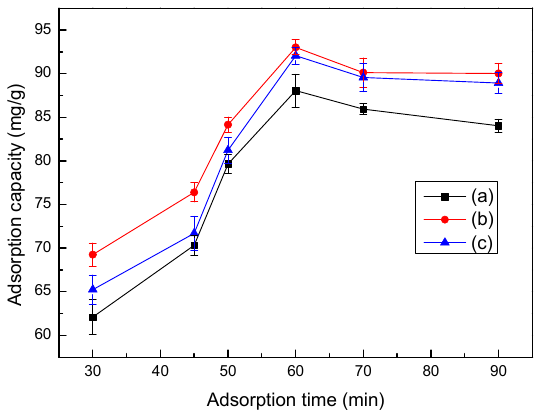
Figure 9. Effects of adsorption time on adsorption by LMT at various initial Co(II) concentrations of (a) 0.0035 M, (b) 0.0040 M, and (c) 0.0042 M.